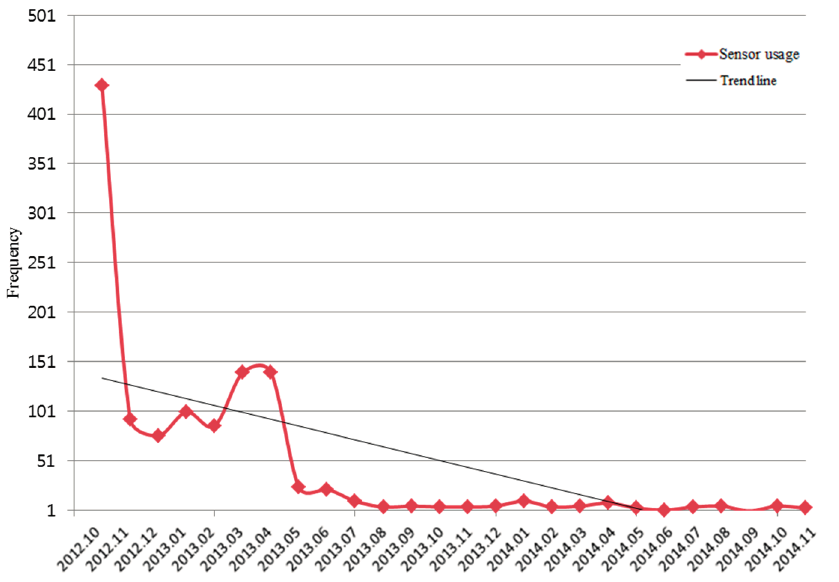
Figure 6. Frequency of sensor usage in “My Cancer Diary” by month.